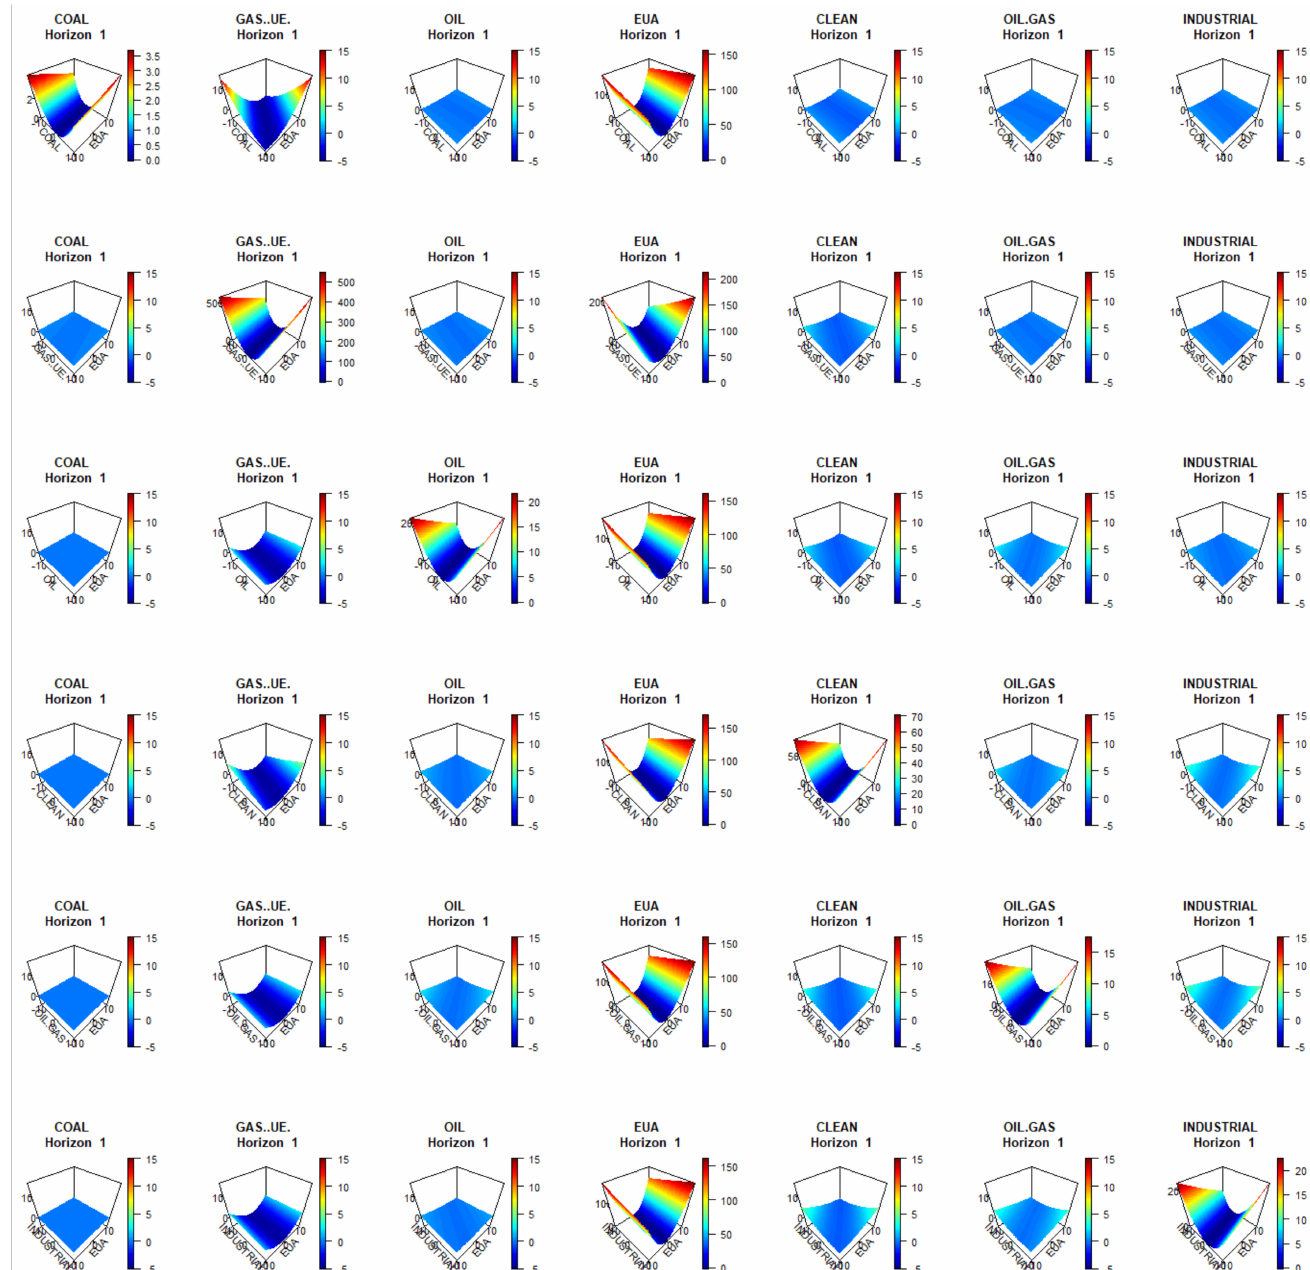
Figure 11. Matrix graph with the response surfaces of the conditional volatility of all of the seven variables (by column) to bivariate impulses in all pair combinations of each variable with EUA (by